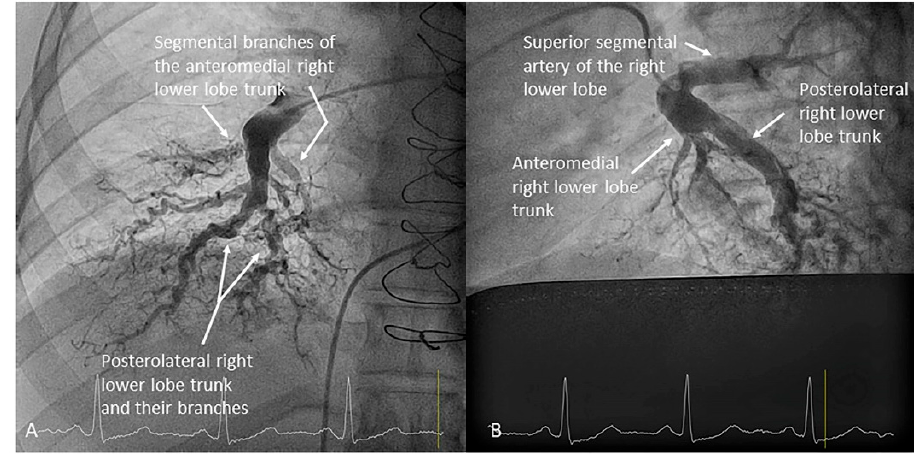
Figure 16. Branches for the right lower lobe: ( A ) anteroposterior view and ( B ) lateral view.